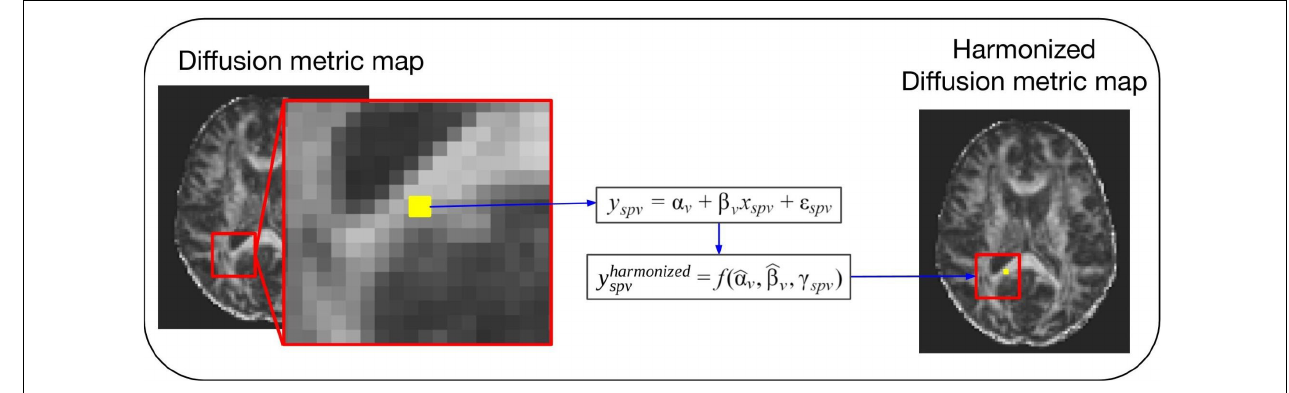
FIGURE 2 | General scheme of a voxel-wise regression of covariates harmonization approach. For these methods the voxel intensity of the diffusion metric maps ( y spv , the intensity for a specific site s , subject p and voxel v ) is modeled as a combination of a voxel-wise intercept ( α v ), a voxel-wise slope ( β v ) multiplied by a model-specific dependent variable ( x spv ), and an error component ( ε spv ). Each of the regression of covariates approaches will have a different model and dependent variable to describe the biological and site-related effects on the diffusion metric intensities. Next, the estimated coefficients are used to compute the new harmonized diffusion intensity values ( y harmonized spv